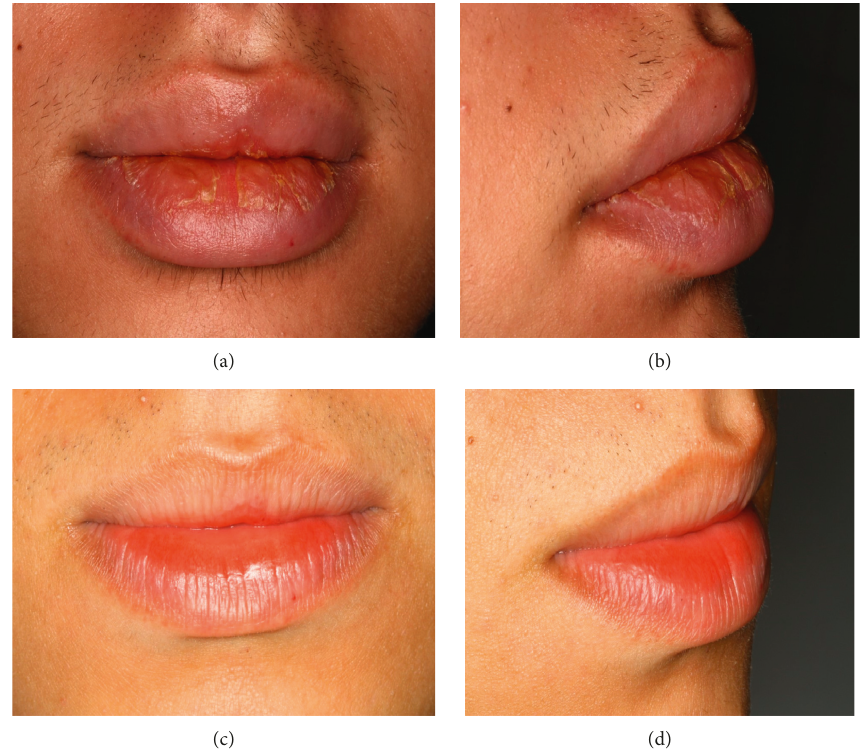
Figure 1: (a, b) Initial consultation with the patient exhibiting yellowish crusts on the labial mucosa. The lips (mainly the lower one) are also swollen and everted, whereas the vermilion border appears unaffected. (c, d) After treatment, both lips regained normal contour and aspect. A discreet redness of the lip mucosae remained unchanged throughout the